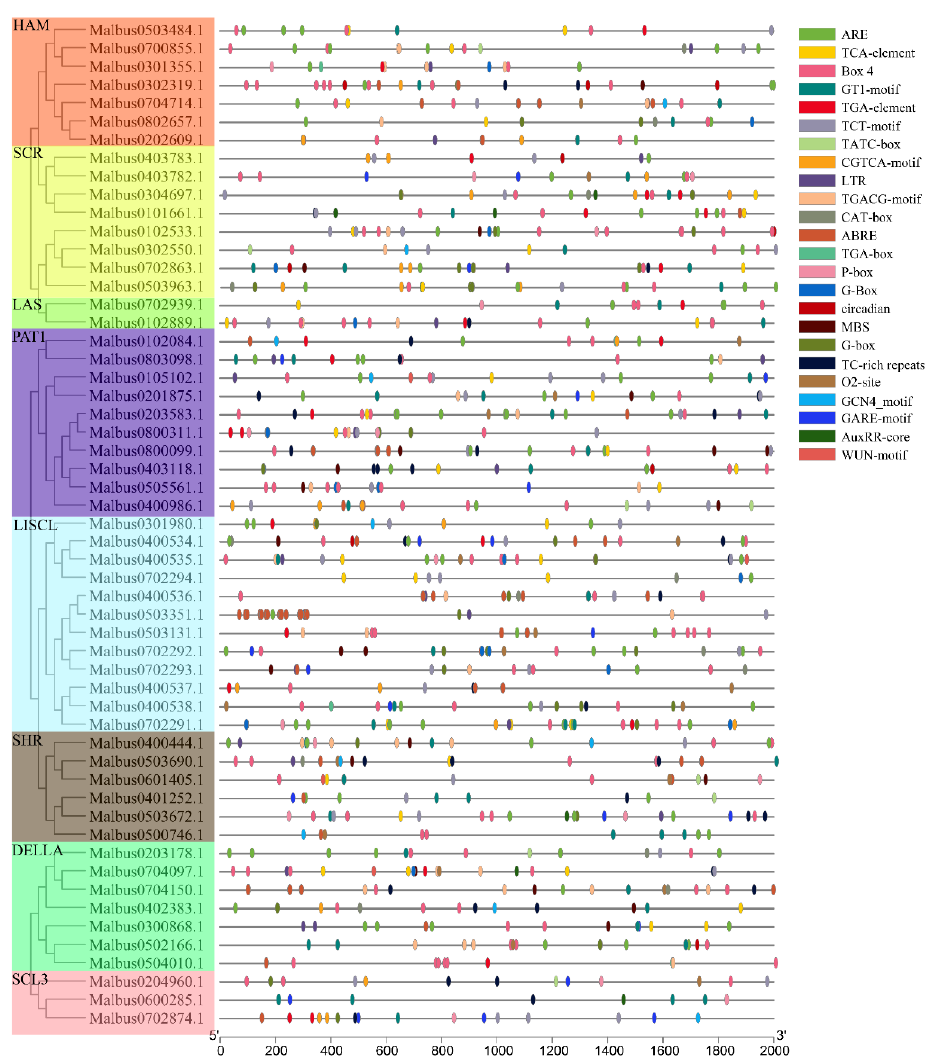
Figure 5. The cis − acting elements of promoter sequences ( − 2000 bp) of 55 MaGRAS genes are ana- Figure 5. The cis–acting elements of promoter sequences ( − 2000 bp) of 55 MaGRAS genes are lyzed by PlantCARE in M. albus . analyzed by PlantCARE in M. albus